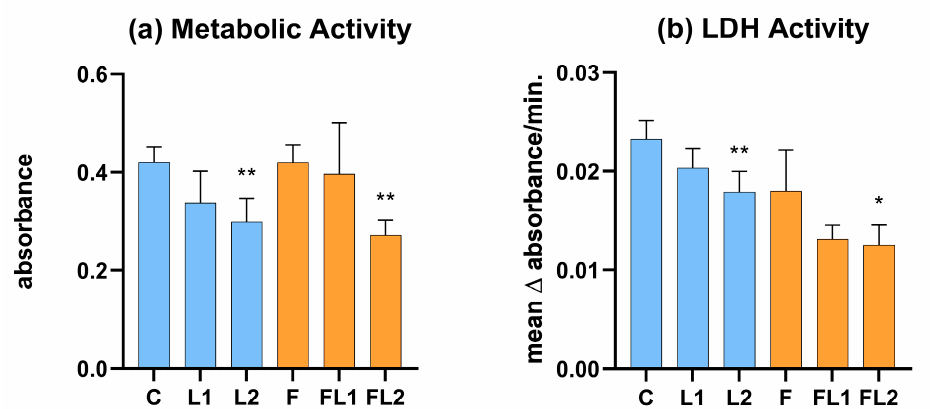
Figure 2. Metabolic activity measured by CCK-8 assay ( a ) and extracellular lactate dehydrogenase activity measured by an enzyme kinetic photometric assay ( b ). C = control, L1 = luteolin (4 µg/mL), L2 = luteolin (16 µg/mL), F = flagellin (250 ng/mL), FL1 = flagellin (250 ng/mL) and luteolin (4 µg/mL), FL2 = flagellin (250 ng/mL) and luteolin (16 µg/mL). Mean ( n = 6/group) ± SD, * p < 0.05, ** p < 0.01. Group L1, L2 and F were compared to C, while group FL1 and FL2 were compared to group F.